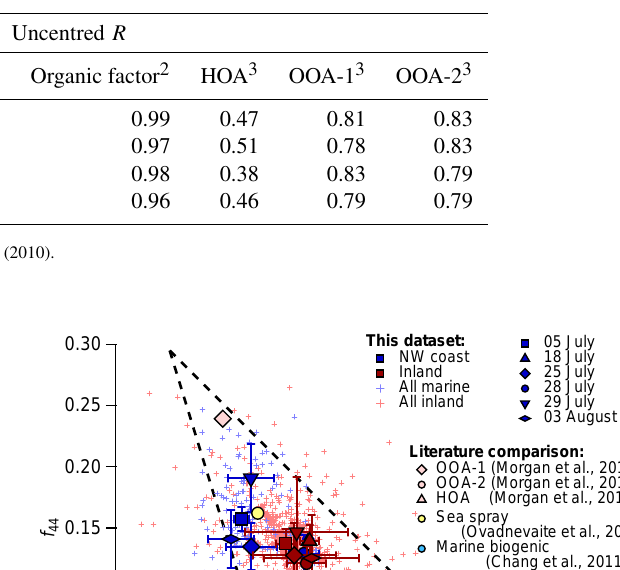
Table 3. Uncentred R (also known as normalised dot product) between marine OA measured on the SWW case studies and several literature spectra. m/z 28 was not used for the correlations due to gas-phase interference.